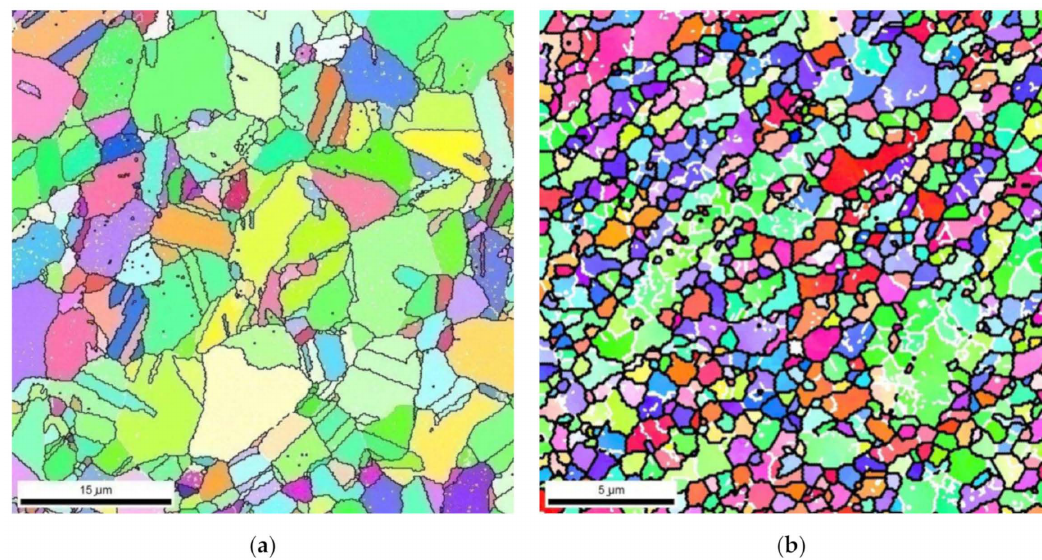
Figure 6. Microstructure orientation maps: ( a ) initial state; and ( b ) after six deformation cycles by HPT method.